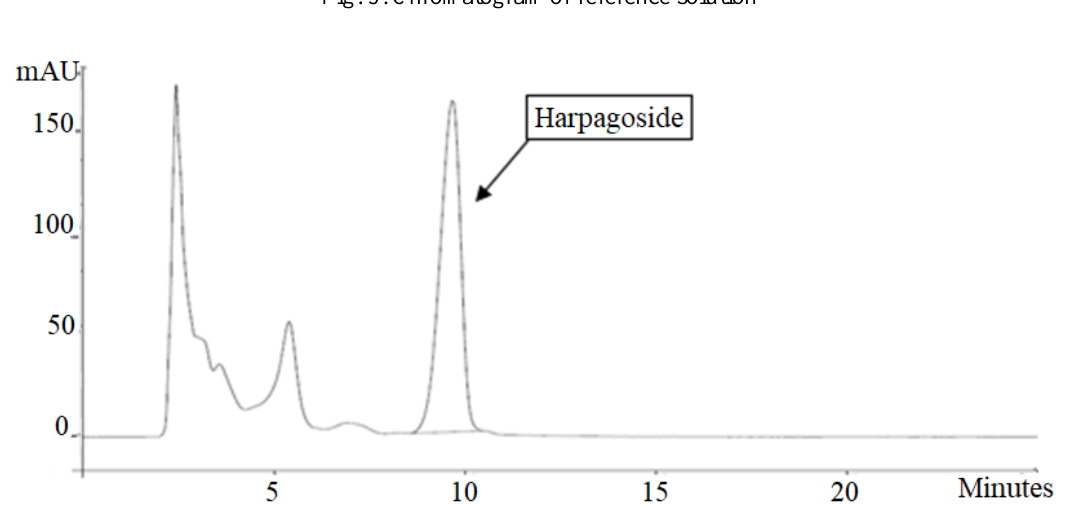
Fig. 3. Chromatogram of reference solution